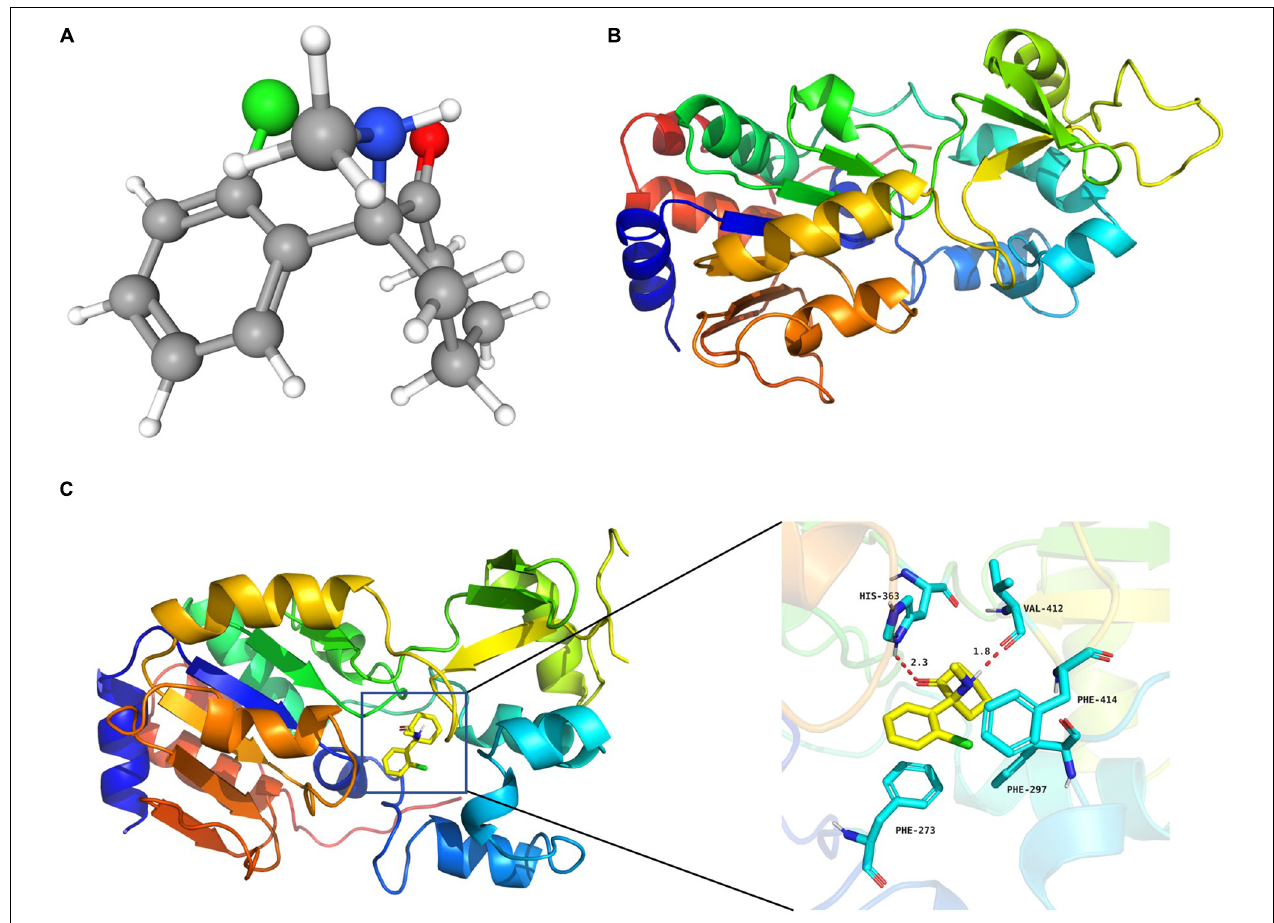
FIGURE 3 | S-ketamine interacted with SIRT1 at the molecular level. (A) 3D structures of S-ketamine obtained from PubChem. (B) 3D structures of SIRT1 protein obtained from the PDB. (C) S-ketamine was anchored in the hydrophobic pocket of the protein.